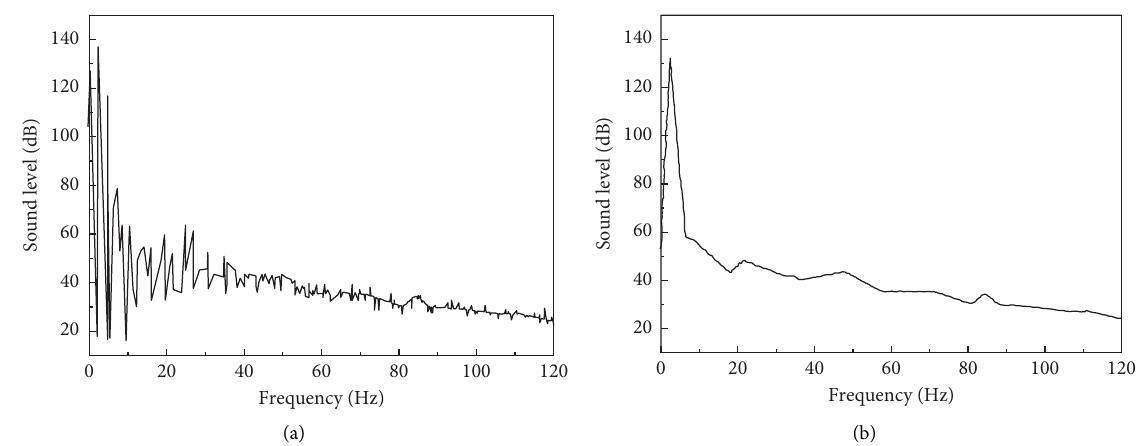
Figure 11: Denoised building vibration signal by EMD and IEMD-IWFD